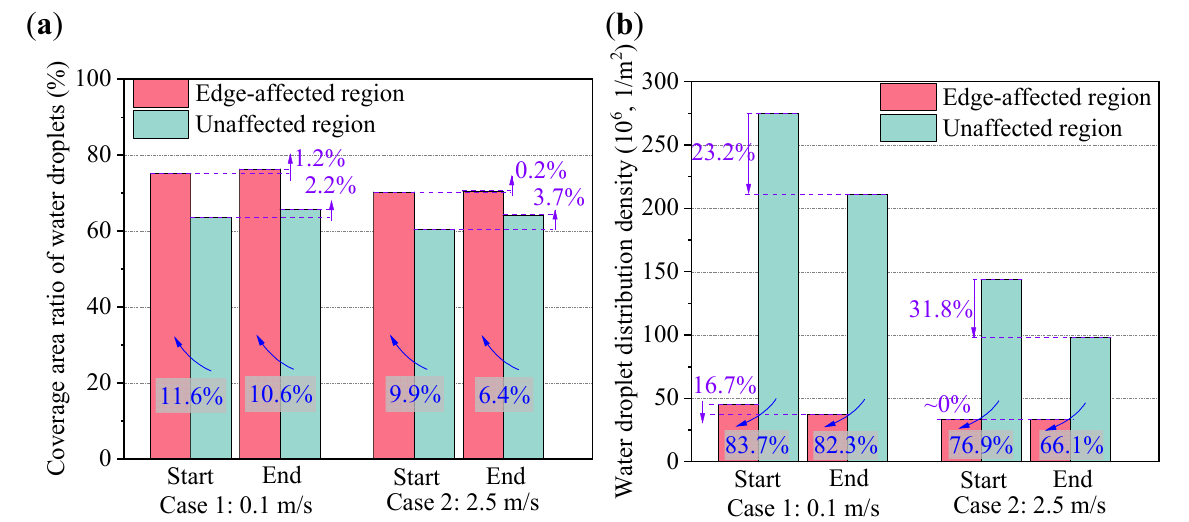
Figure 11. Water droplet distribution characteristics: ( a ) coverage area ratio, and ( b ) distribution density of water droplets.